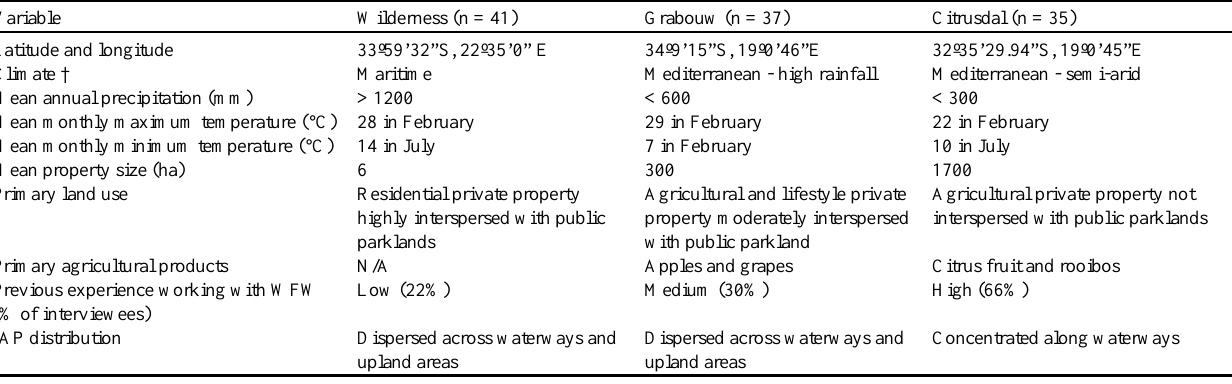
Table 2 . Characteristics of landowner study sites, Western Cape (n = number of respondents at each